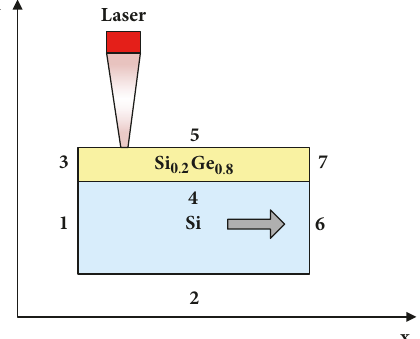
Figure 2: The simulated model of the CW laser recrystallization Si 0.2 Ge 0.8